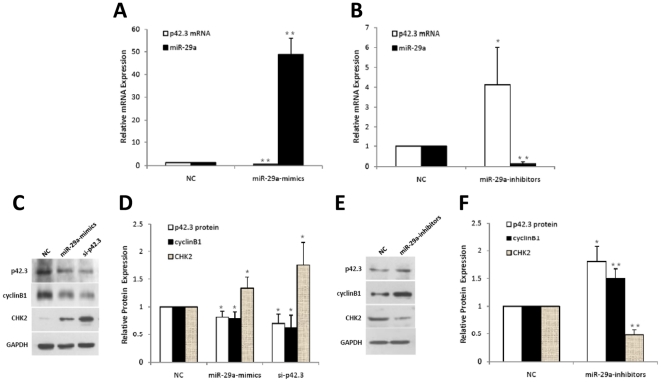
Regulation of endogenous p42.3 expression by miR-29a.
A. Effect of miR-29a mimics on the endogenous expression of p42.3 mRNA. Mature miR-29a was exogenously upregulated while the endogenous expression of p42.3 mRNA was significantly downregulated in MKN-45 cells. **: P<0.01. B. Effect of miR-29a inhibitors on the endogenous expression of p42.3 mRNA. Mature miR-29a was exogenously downregulated, while the endogenous expression of p42.3 mRNA was significantly upregulated in MKN-45 cells. *: P<0.05, **: P<0.01. C and D. Effect of miR-29a mimics on the endogenous expression of p42.3, cyclin B1 and CHK2 proteins were similar to those of si-p42.3. The expression levels of p42.3 and cyclin B1 protein decreased significantly after MKN-45 cells were treated with si-p42.3 or miR-29a mimics while the level of CHK2 protein increased dramatically. Data are shown as mean ± SD (normalized; D). *: P<0.05. E and F. Effect of miR-29a inhibitors on the endogenous expression of p42.3, cyclin B1 and CHK2 protein. MiR-29a inhibitors reversed the expression changes seen in C and D. *: P<0.05, **: P<0.01.